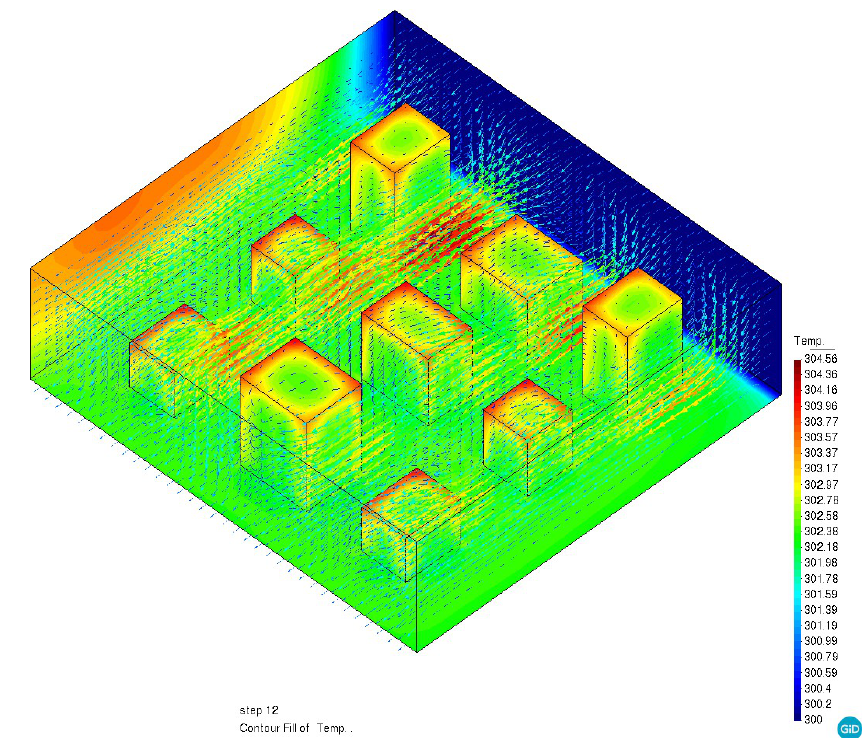
Figure 4. Microclimate model at time T = 10,800 s.